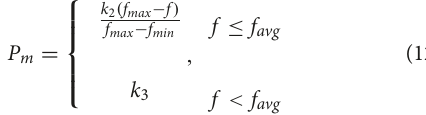
FIGURE4 acquisition of vertices in tea